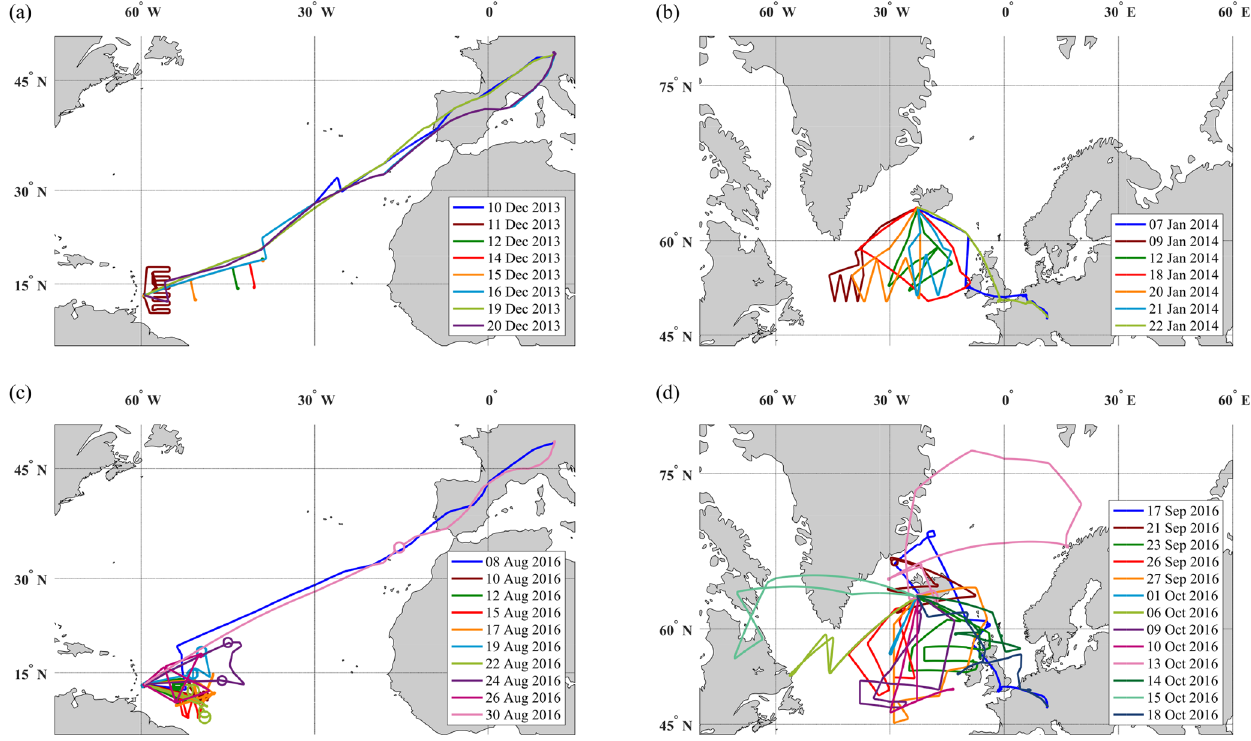
Figure 1. Flight tracks from all four campaigns: NARVAL-South (a) , NARVAL-North (b) , NARVAL2 (c) , and NAWDEX (d) .